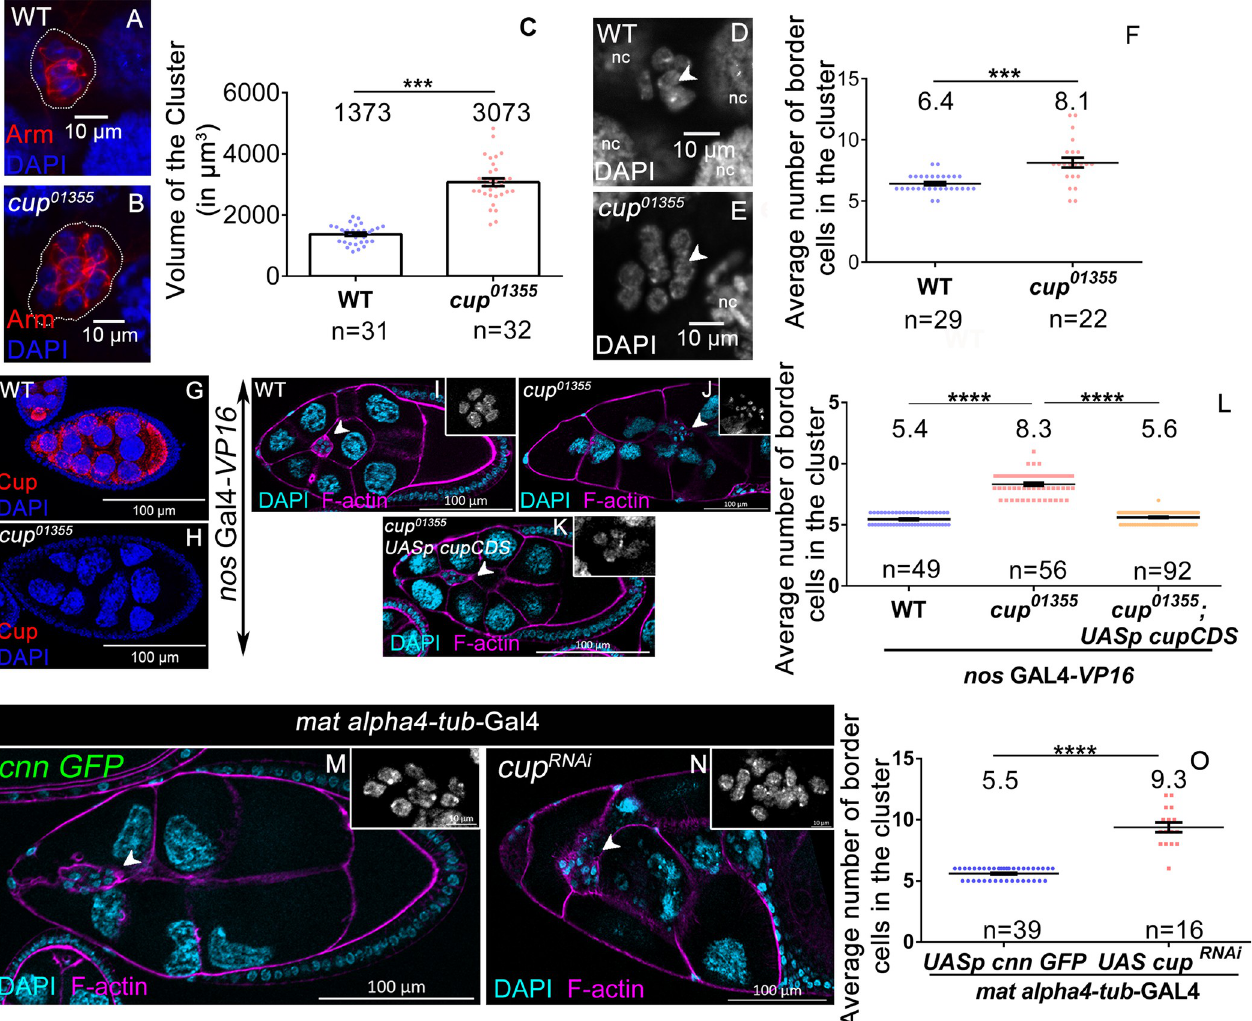
Fig 1. Cup functions in the germline cells to limit the size of the BC cluster. ( A-C ) cup 01355 egg chambers exhibit larger border cell cluster, Armadillo (red), DAPI (blue), White dotted line marks BC cluster. ( D-F ) cup 01355 egg chambers exhibit increased cell count, DAPI (grey), compared to wild type. ( G-H ) cup 01355 egg chambers lack Cup Expression, Cup (red), DAPI (blue). ( I-L ) Increased BC number (white arrow) is rescued by UASp-CupCDS , driven by nos . GAL4 -VP16 in cup 01355 egg chambers, F-actin (magenta), DAPI (cyan, grey in inset). Student t-test, p value between WT and cup 01355 is < 0.0001 indicated by ���� , p value between cup 01355 and UASp-CupCDS in cup 01355 background is < 0.0001 indicated by ���� , p value between WT and UASp-CupCDS in cup 01355 background is 0.0698 indicated by ns (not significant). (M-O) Down regulation of Cup in germline by overexpressing cup RNAi with germline mat alpha4-tub- GAL4 exhibit increased border cell count compared with control, F-actin (magenta), DAPI (cyan, inset in grey). n represents the number of egg chambers evaluated. SEM represent the error bars.